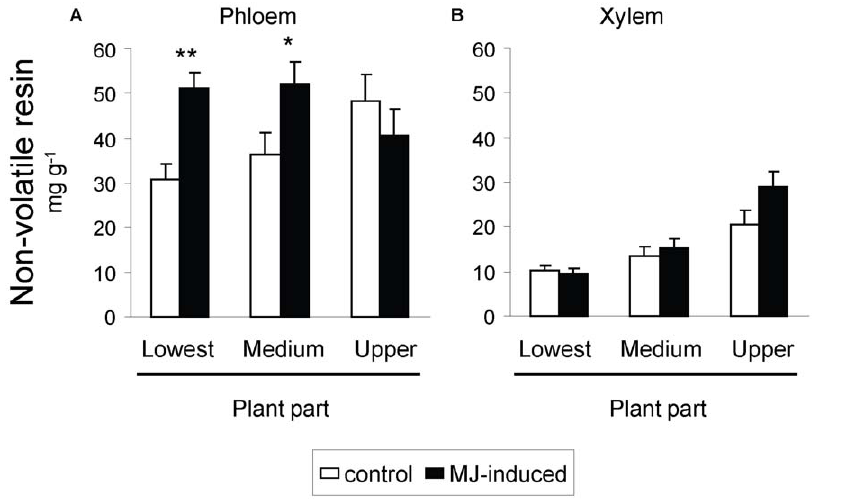
Figure 2. Allocation of constitutive and induced non-volatile resin across different pine parts. Non-volatile resin concentration in (a) the phloem and (b) the xylem across three parts of the plants (basal, middle and apical upper part) in control (constitutive, white bars) and methyl jasmonate (MJ) induced (black bars) P. radiata juveniles. Plants were destructively sampled 15 days after application of MJ. Bars are means 6 s.e.m. (N=8). Asterisks indicate significant differences within each plant part due to MJ-induction at P , 0.05 (*) and P , 0.01 (**).